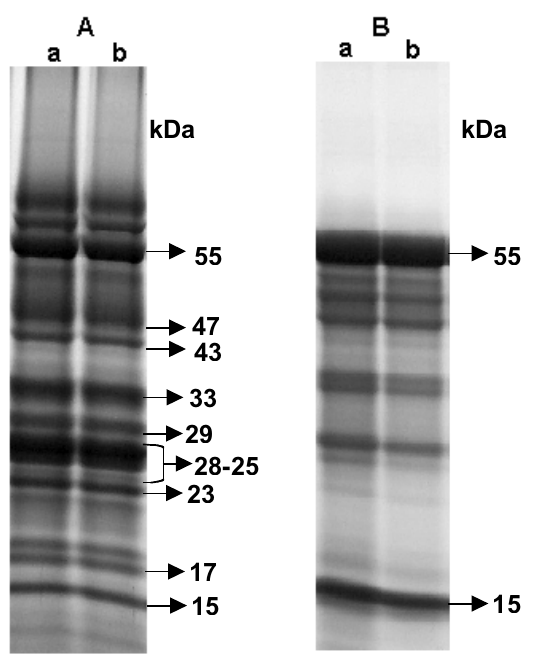
Fig. 4. Coomassie blue stained polypeptide profiles of thylakoid membranes (A) and crude leaf extracts (B) isolated from noninfected (NI) and virus-infected (VI) Vitis vinifera leaves. Gel lanes were loaded with equal amounts of protein (100 µg). a, NI; b , VI.